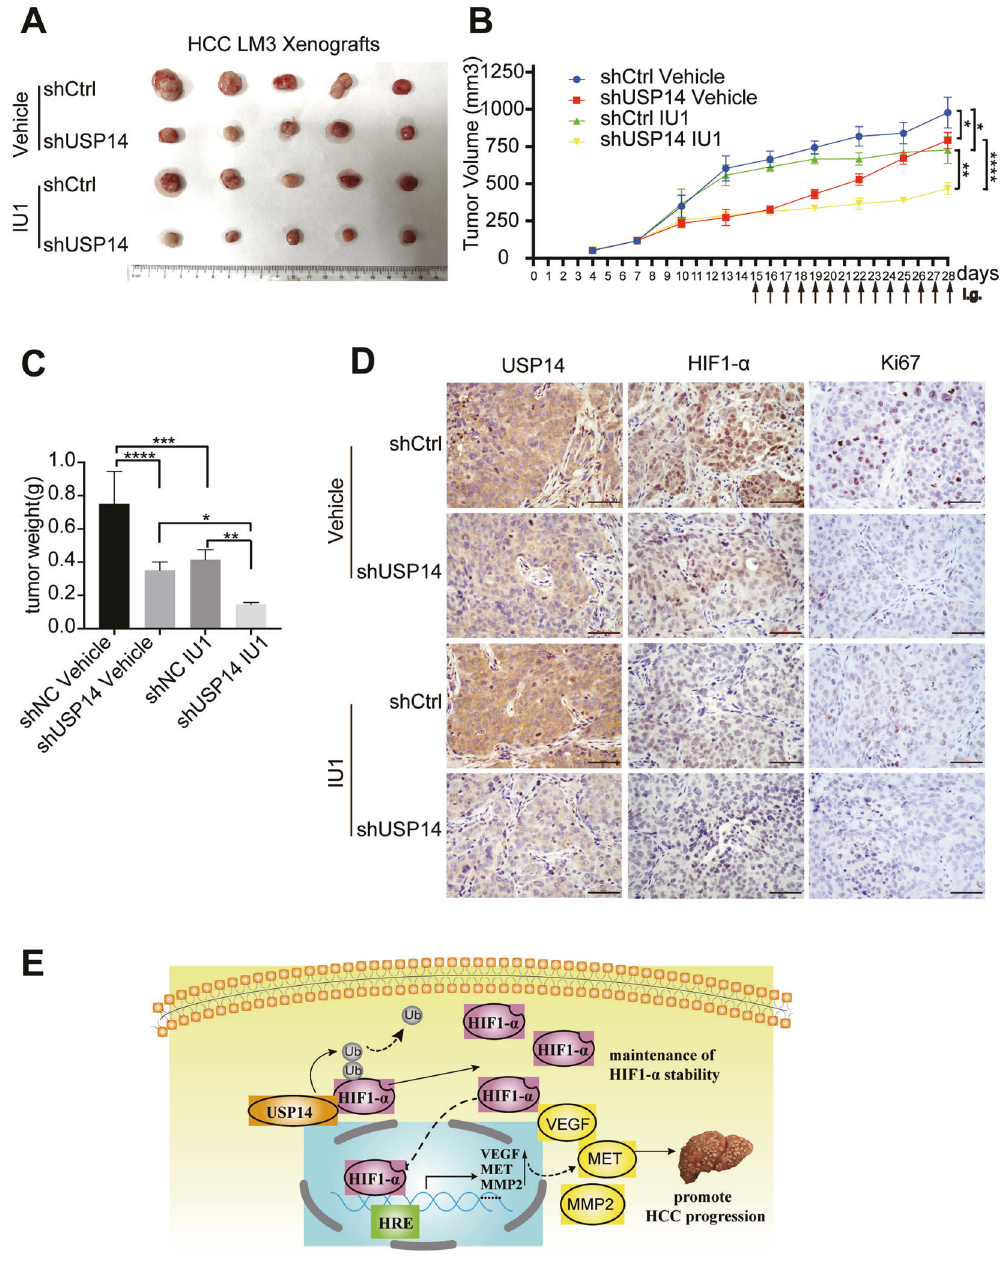
Fig. 8 Co-treatment of IU1 and USP14 knockdown suppresses HCC cell growth in mice. A – C BALB/c nude mice, at two weeks after inoculation with HCCLM3 cells stably expressing either human USP14-speci fi c shRNA or control shRNA, were administrated orally with IU1 (40 mg/kg, every two days) for 14 days. Xenograft images ( A ), tumor volume ( B ), and tumor weight ( C ) were presented. * P < 0.05; ** P < 0.01; *** P < 0.001; **** P < 0.0001; ns = no signi fi cance. D Representative micrographs of immunohistochemistry staining for USP14, HIF1- α , and Ki67 in explanted tumor tissues. Scale bar, 100 μ M. E The schematic diagram of USP14 promotes the procession of HCC by stabilizing HIF1- α and activating HIF1- α transcription via